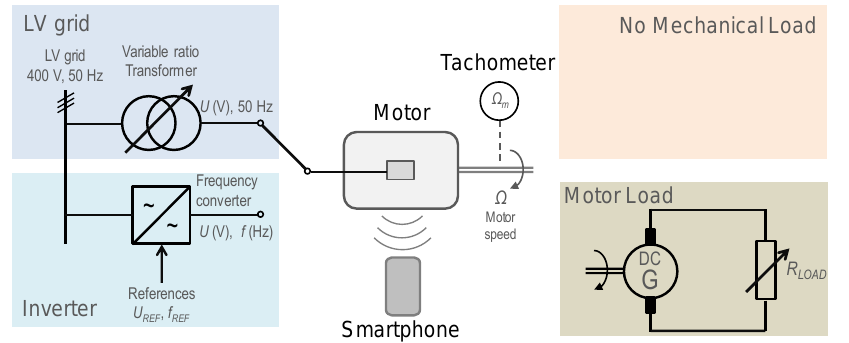
Figure 1. Sketch of the configuration of the different tests carried out on the induction motor. Once the appropriate test configuration was decided upon, that is, the voltage source of the motor (variable ratio transformer or inverter) and the mechanical load (DC generator with a load resistance, or no mechanical load at all), the tests on the laboratory bench were performed. After setting the proper voltage source and mechanical load, the voltage (and frequency in the case of inverter) and the load resistance (in the case of DC generator) were adjusted to reach the desired conditions of load and shaft speed. Once the value of the rotor speed was verified, a smartphone placed just in front of the nameplate of the motor was used to acquire and record the motor noise by means of the apps. The recorded *.wav